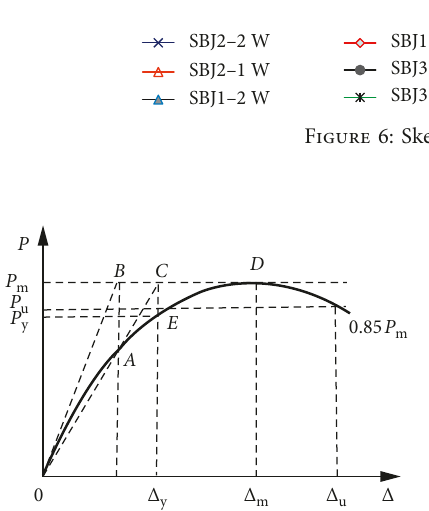
Figure 7: Determination for the yield load in